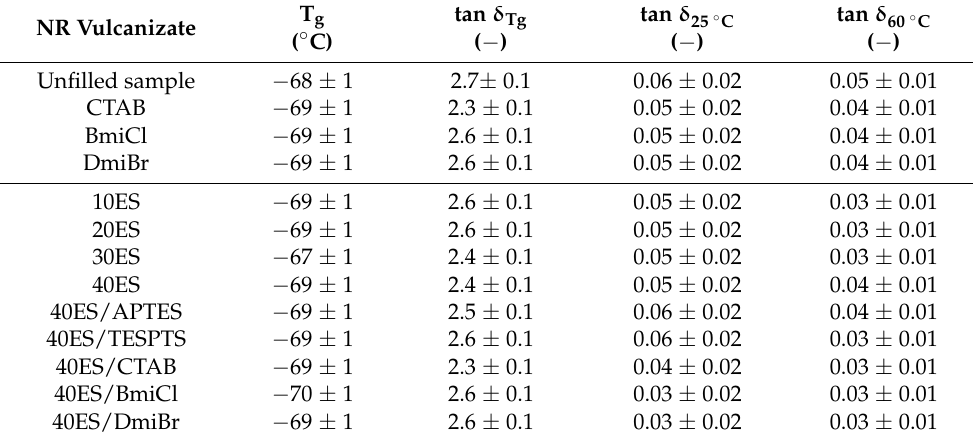
Table 7. Glass transition temperature (T g ) and loss factor (tan δ ) of NR vulcanizates measured by DMA. NR Vulcanizate